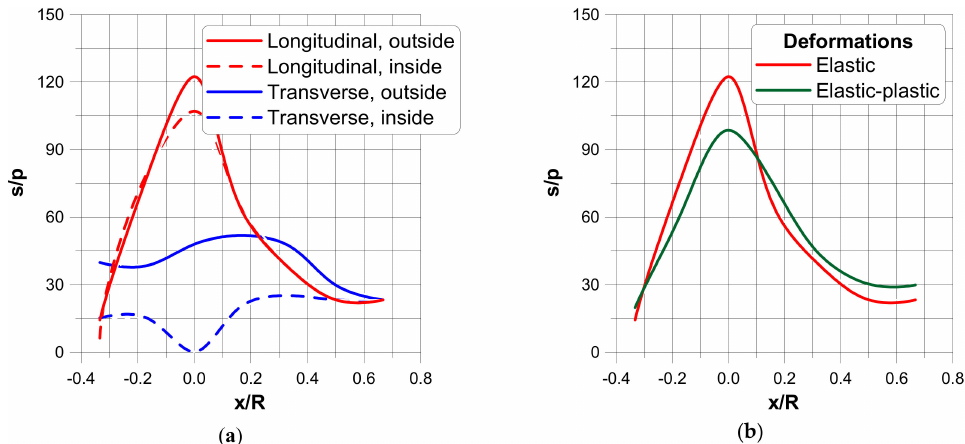
Figure 6. Stress distributions in a direction parallel to the transverse and longitudinal planes. ( a ) elastic deformations. ( b ) comparison of elastic and elastic plastic stress distributions.